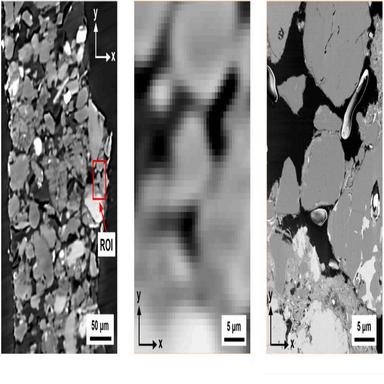
Acquired images from μXCT and FIB-SEM tests. (a) A selected slice from the 3D images obtained from μXCT with the ROI for FIB-SEM marked. (b) View of the μXCT slice enlarged to the FIB-SEM ROI. (c) The FIB-SEM slice corresponding to the view in (b).